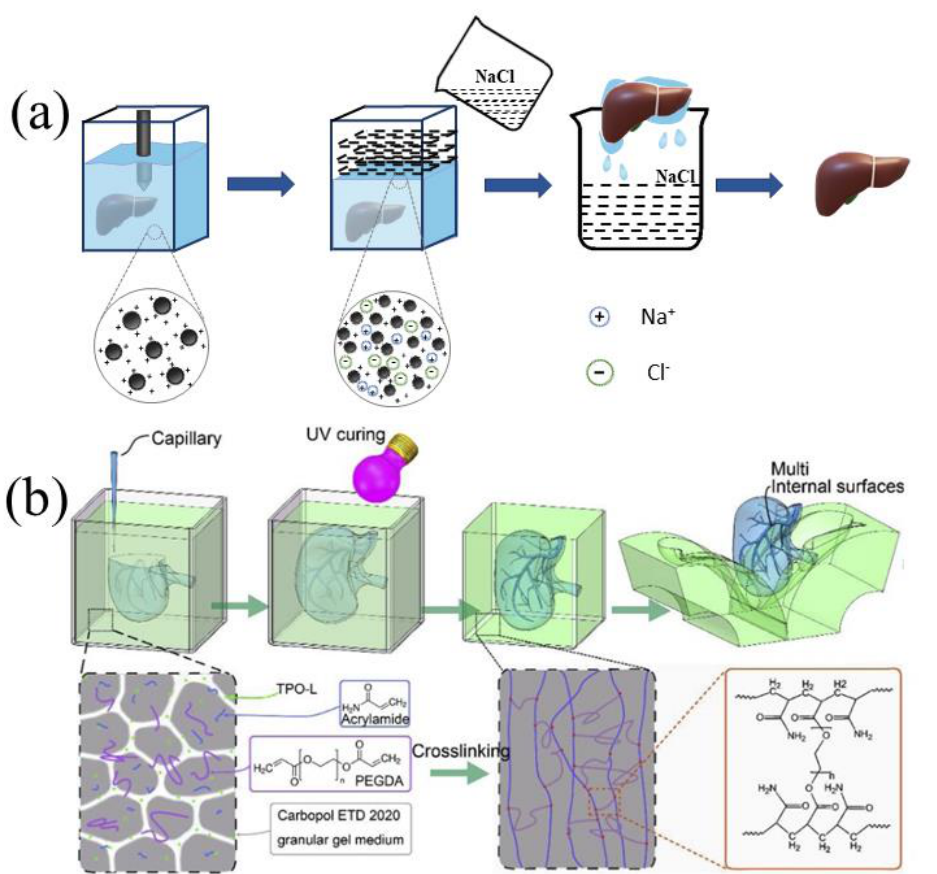
Figure 6. ( a ) Changing the rheology of the Carbopol bath by shielding the electrostatic repulsion between Carbopol ions to remove the Carbopol support bath. ( b ) After photo-crosslinking, the Carbopol support bath was removed by mechanical peeling [43], Reprinted with permission from